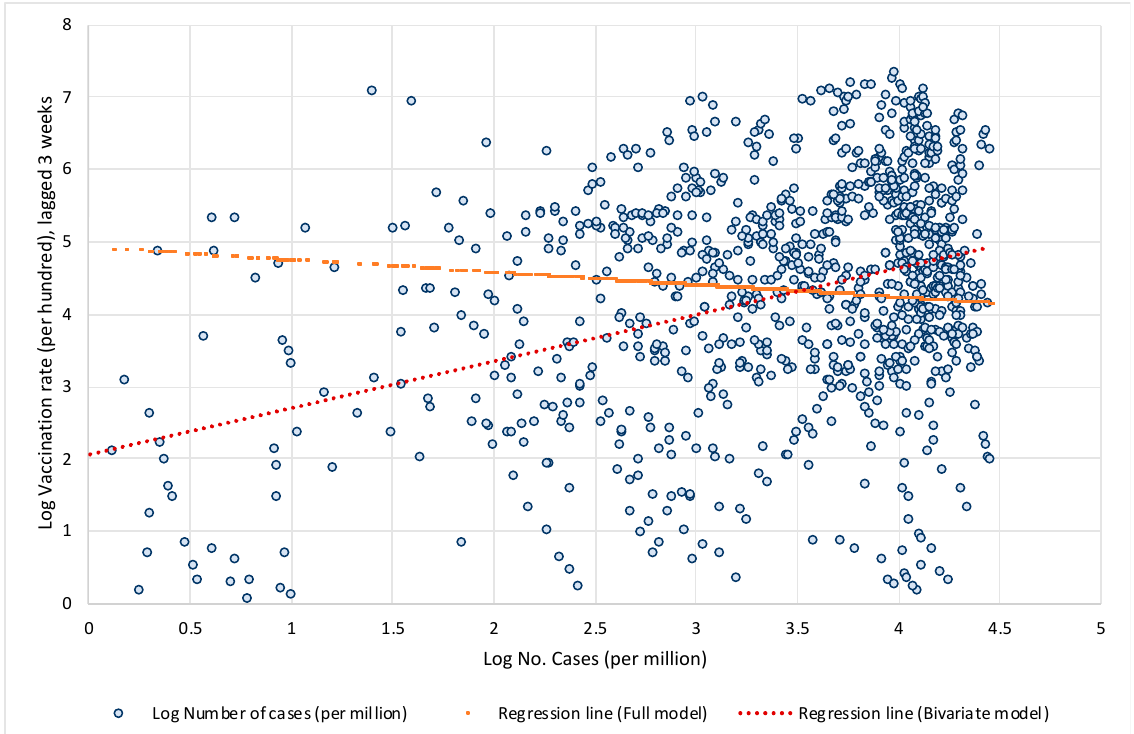
Figure 2. Log vaccination rate and log number of cases per million. Notes: Based on results presented in Table A1 in the Appendix. Data by weeks, period 1 August to 14 November 2021, for 110 countries. Data are specified in natural logarithms; data on vaccination are lagged by 3 weeks. For the Full model the constant term was scaled up. Source: Our World in Data; own calculations.